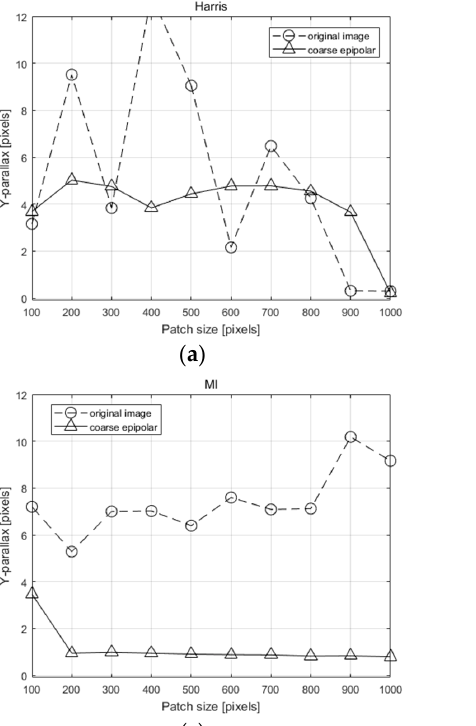
25 of 29 Figure 22. Y-parallax (along-track Kompsat-3): ( a ) HARRIS–FREAK ( b ) SURF, ( c ) MI, and ( d ) PC.